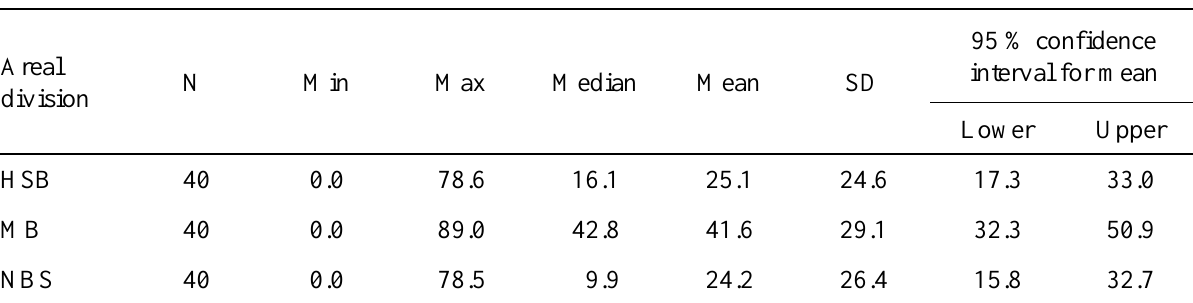
Table 7. The proportion of an aapa mire's catchment that is upslope of a drained margin (%).